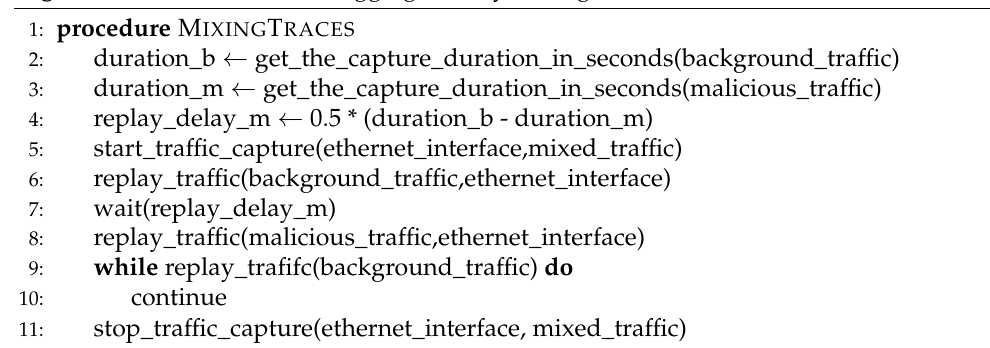
Algorithm 2 Malicious traffic aggregation by mixing network